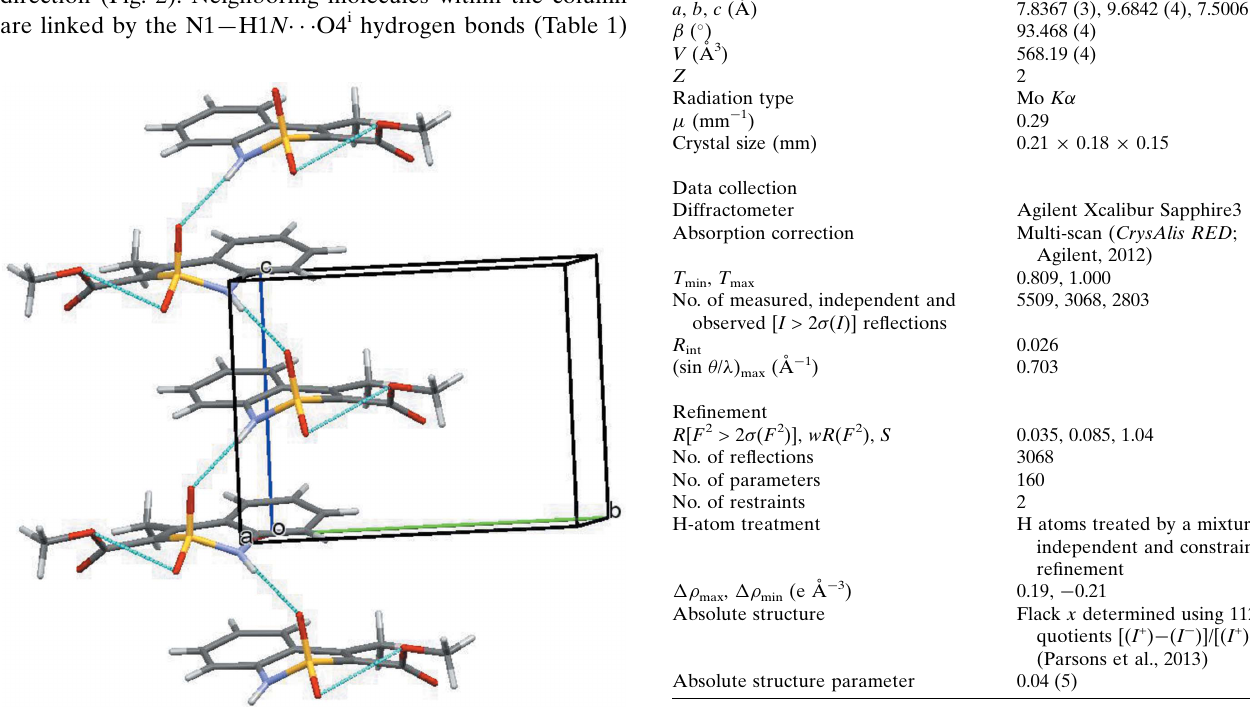
Figure 2 The packing showing columns of molecules along the c- axis direction.